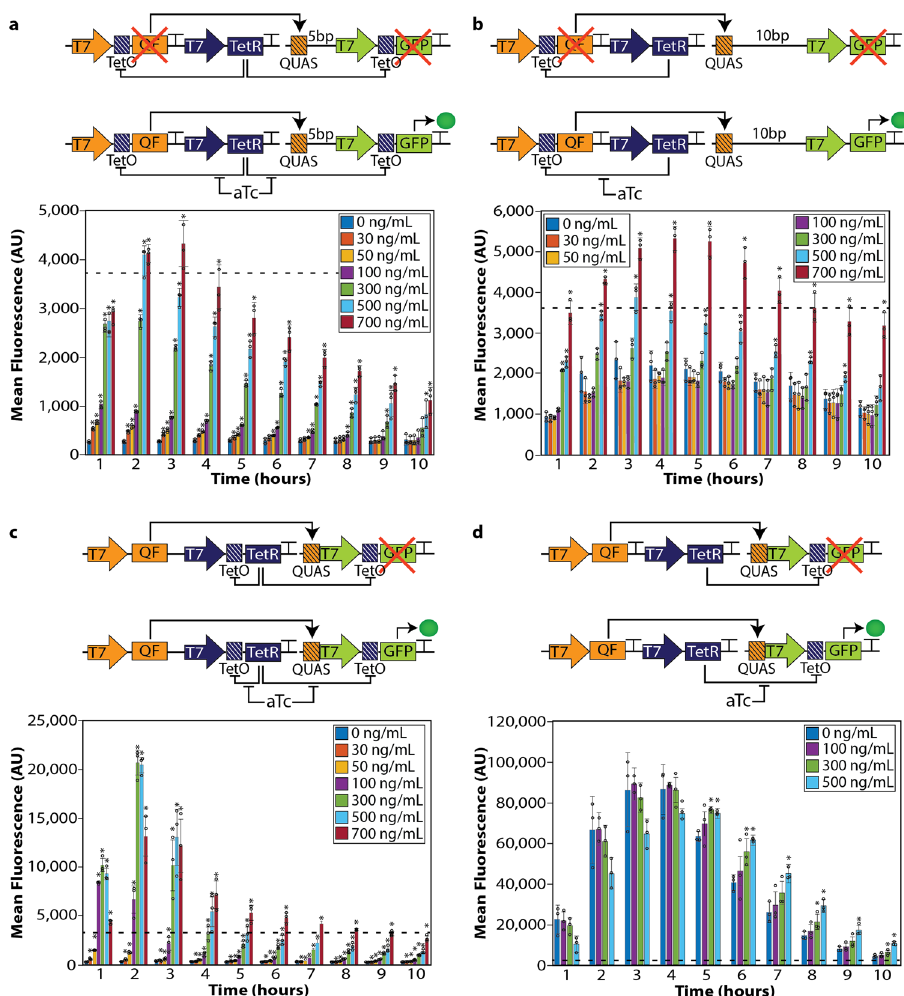
Fig. 4 Genetic devices built with components from the Q system coupled with the TetR system. a Biological sensor with QUAS (orange box with lines) placed 5 base pairs upstream of the T7 promoter driving the expression of GFP (green). A TetO site (blue square with lines) was placed upstream of GFP and QF. The tetR gene is constitutively expressed by a T7 promoter (blue arrow). Schematic in the absence of aTc (top) indicates that both the expression of QF (orange rectangle) and GFP (green rectangle) is repressed by TetR proteins since T7RNAP cannot bind. Schematic when aTc is added to the system (bottom), the TetR proteins no longer prevent T7RNAP from binding, and transcription of QF and GFP turns on. Flow cytometry quantifying the amount of GFP expression with varying amounts of aTc. b Biological sensor with QUAS (orange box with lines) placed 10 base pairs upstream of the T7 promoter driving the expression of GFP (green). The tetR gene (blue) is constitutively expressed by a T7 promoter (blue). Schematic in the absence of aTc indicates that both the expression of QF and GFP is repressed by TetR proteins (top). Schematic when aTc is added to the system, the TetR proteins no longer prevent T7RNAP from binding, and transcription of QF and GFP turns on (bottom). Flow cytometry quantifying the amount of GFP expression with varying amounts of aTc. c Low pass sensor. In this design, the T7 terminator sequence between the QF and tetR genes was removed to produce more TetR proteins. QUAS was placed directly upstream of the T7 promoter driving GFP expression. A TetO site is located upstream of both the GFP and tetR genes so they can be regulated by aTc. Schematic of the low pass sensor in the absence of aTc (top). Schematic of the low pass fi lter in the presence of aTc (bottom). Flow cytometry quantifying the amount of GFP expression with varying amounts of aTc. d Genetic device to produce large quantities of protein. This genetic circuit has QUAS placed directly upstream of the T7 promoter driving the expression of GFP . A TetO site was placed upstream of GFP to regulate its expression with aTc. In this circuit, the QF is constitutively expressed and binds to QUAS. Schematic in the absence of aTc, TetR binds to the TetO sites to repress the expression of GFP (top). Schematic when aTc is added to the system, the TetR proteins no longer bind, enabling the T7RNAP to bind and transcribe GFP (bottom). Flow cytometry quantifying GFP expression with varying amounts of aTc. In all experiments, the dotted line indicates the maximum expression of the traditional TetR system without the Q system (~3700 arbitrary units). GFP was quanti fi ed for all constructs using fl ow cytometry over a 10-h period after the initial induction of 0.5 mM IPTG (added at time zero to initiate transcription of T7RNAP , allowing transcription of T7- controlled genes. Each experiment consisted of generating data from at least three separate bacterial colonies grown in overnight cultures, where circles represent individual data points in the plots. These experiments were repeated independently at least three times with similar results. A two-tailed t -test was performed to determine statistical signi fi cance ( P < 0.05) between the 0 ng/mL of aTc with each induction amount over 10 h. An aster (*) represents statistical signi fi cance. The geometric mean of each sample was calculated via FlowJo, and error bars indicate standard deviation. The error bars indicate 95% con fi dence intervals of the mean of fl uorescence, and data are presented as mean ± standard deviation. Source data are available as a Source data fi